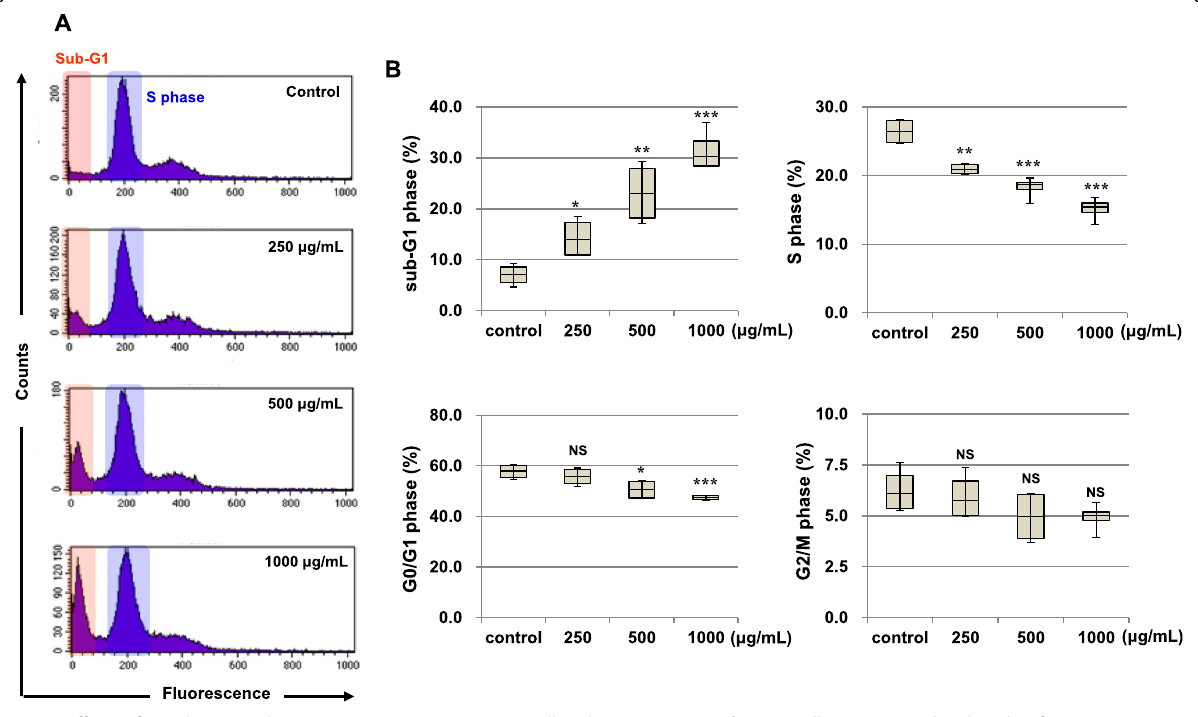
Fig. 2 Effects of Coix lacryma-jobi sprout extract (CLSE) on HeLa cell cycle progression. a, b HeLa cells were stained with BrdU after treatment with CLSE (0 – 1000 μ g/mL) for 72 h, and cell cycle distribution was monitored using flow-cytometric analysis. Dose – response graphs demonstrating the percentage of sub-G1, S, G0/G1, and G2/M (B) phases from the data displayed in panel ( a ). * p < 0.05, ** p < 0.01, and *** p <